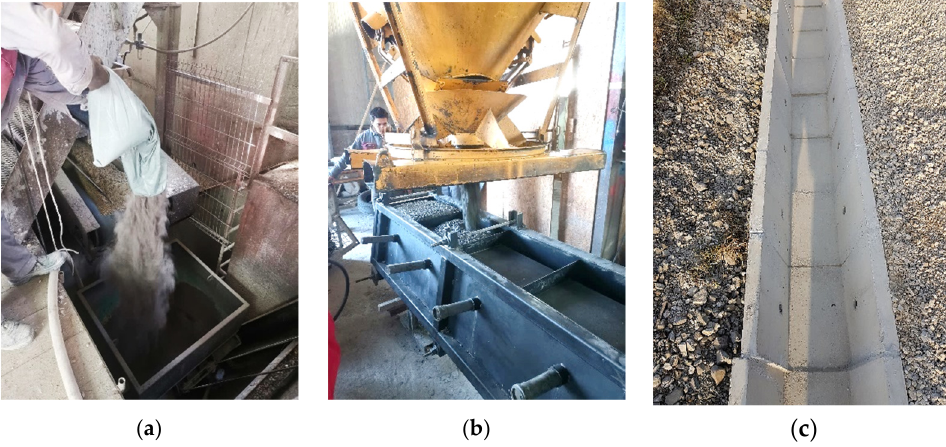
Figure 1. Fabrication of a pilot-scale prototype in an industrial setting: ( a ) manual addition of WBA during concrete mixing; ( b ) filling of curb molds; ( c ) prefabricated drainage elements.